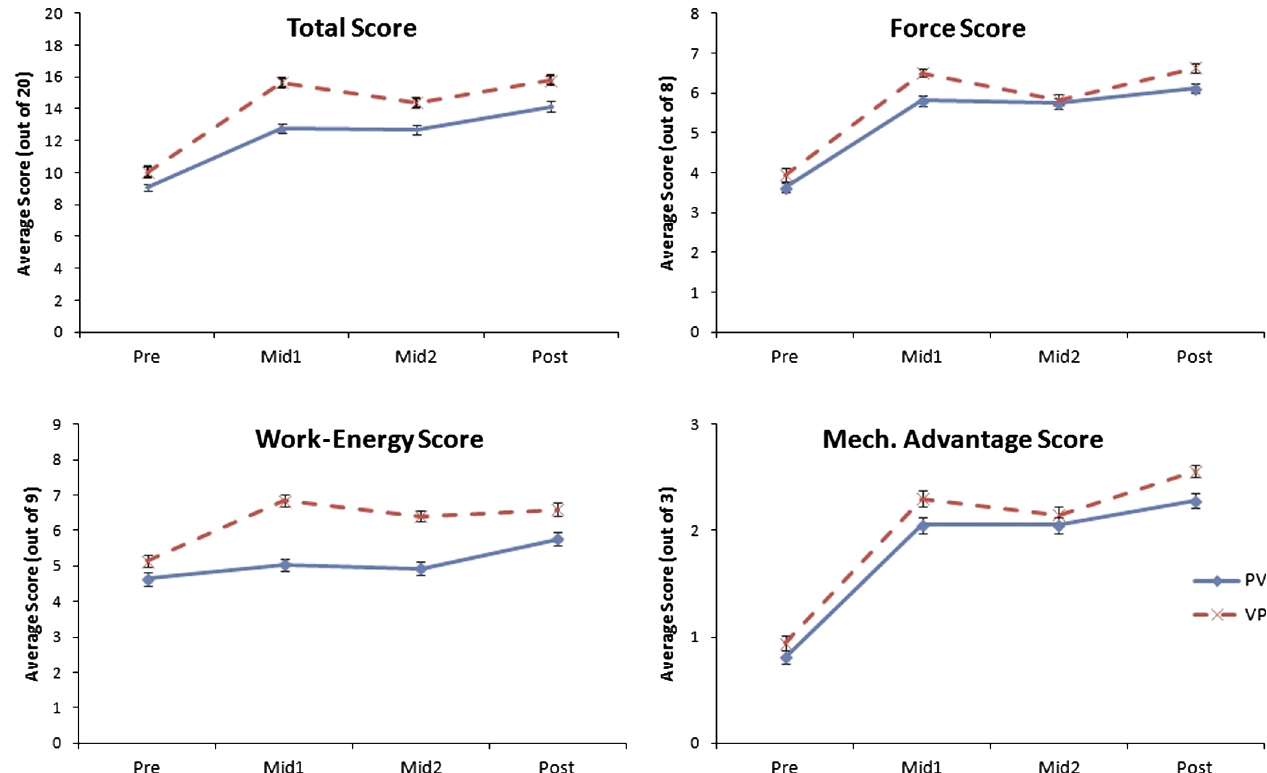
FIG. 5 (color online). Mean score by concept. Error bars represent standard error.